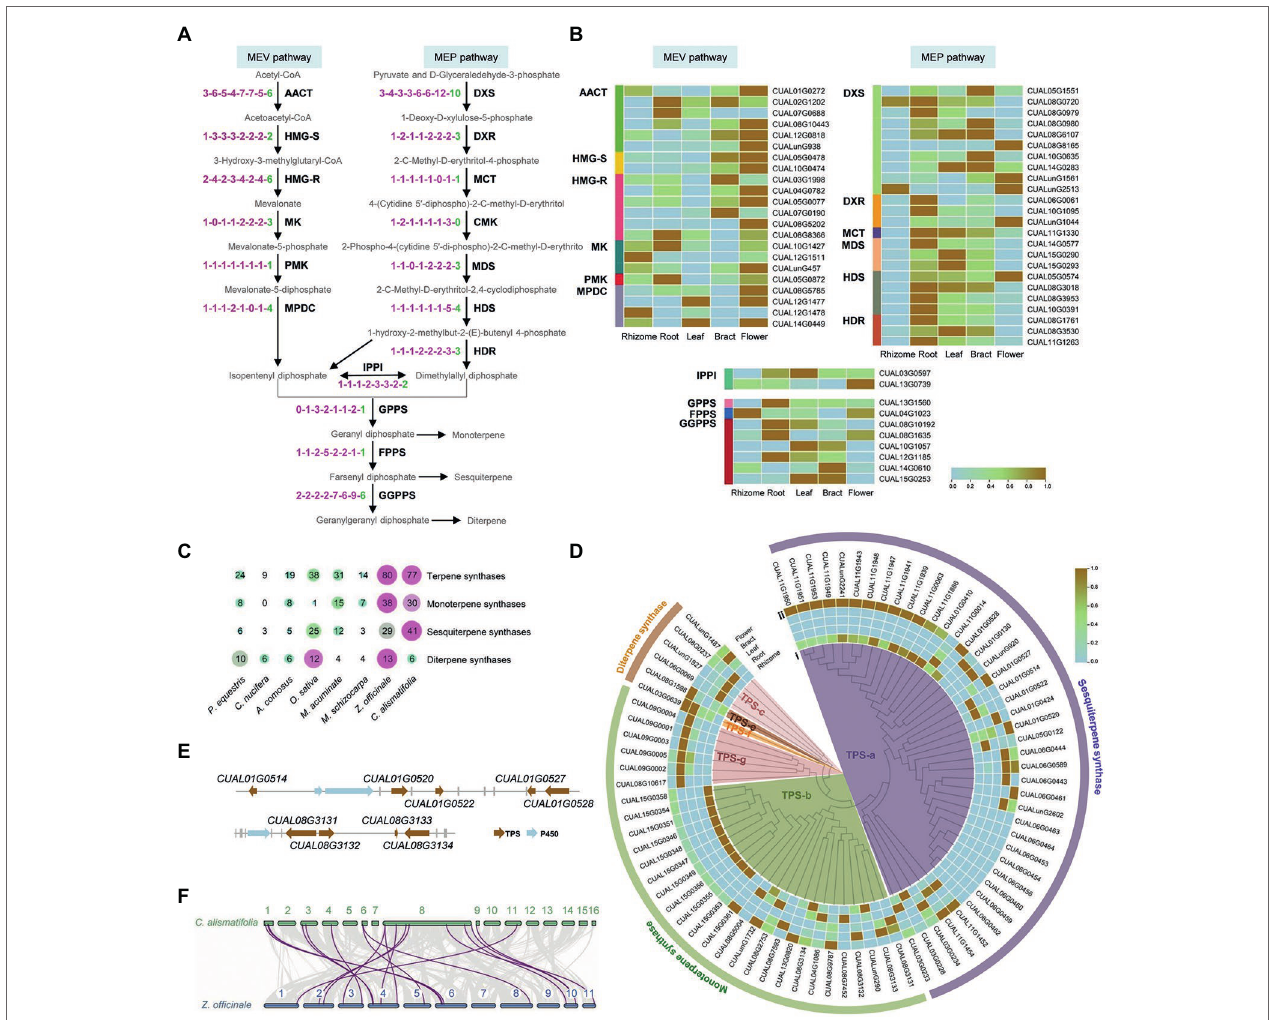
FIGURE 4 | Biosynthesis of terpenoids in C. alismatifolia . (A) The backbone biosynthetic process of terpenoid. AACT, acetyl-CoA C-acetyltransferase; HMG-R, hydroxymethylglutaryl-CoA reductase; HMG-S, hydroxymethylglutaryl-CoA synthase; MK, mevalonate kinase; PMK, phosphor-mevalonate kinase; MPDC, diphosphomevalonate decarboxylase; DXS, 1-deoxy-D-xylulose-5-phosphate synthase; DXR, 1-deoxy-D-xylulose-5-phosphate reductoisomerase; MCT, 2-C-methyl-D-erythritol 4-phosphate cytidylyltransferase; CMK, 4-(cytidine-5-diphospho)-2-C-methyl-D-erythritol kinase; MDS, 2-C-methyl-D-erythritol 2,4-cyclodiphosphate synthase; HDS, (E)-4-hydroxy-3-methylbut-2-enyl-diphosphate synthase; HDR, 4-hydroxy-3-methylbut-2-enyl-diphosphate reductase; IPPI, isopentenyl-diphosphate △ -isomerase; GPPS, dimethylallyltranstransferase/geranyl diphosphate synthase; FPPS, (2E,6E) farnesyl diphosphate synthase; and GGPPS, geranylgeranyl diphosphate synthase. Number of gene encoding these enzymes was compared among eight monocotyledonous plants, i.e., P. equestris , Cocos nucifera , A. comosus , O. sativa , M. acuminate , M. schizocarpa , Zingiber officinale , and C. alismatifolia . The notation “1-1-1-1-1-1-1” indicates one homologous gene was identified among each plant in the order listed in the previous sentence. (B) Expression heatmap of the 56 terpenoid backbone biosynthetic genes in the five tissues. The expression values at the row scale were z-score normalized. Low to high expression is indicated by a change in color from blue to brown. (C) The gene number of terpene synthases (TPS) in the eight plants. (D) The phylogenetic tree and expression heatmap of terpene synthase genes in C. alismatifolia . (i) phylogenetic tree and (ii) expression heatmap. (E) Gene clusters of TPS and P450 genes in C. alismatifolia . (F) Colinear analysis of TPS genes in C. alismatifolia (top) and Z. officinale